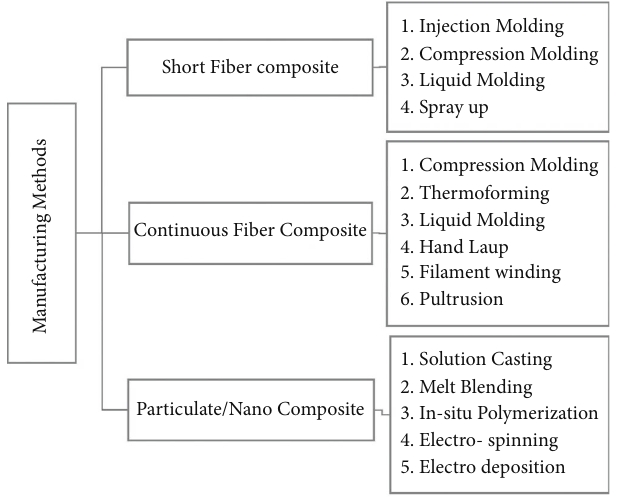
Figure 3: Manufacturing process for PLA polymer composite fabrication